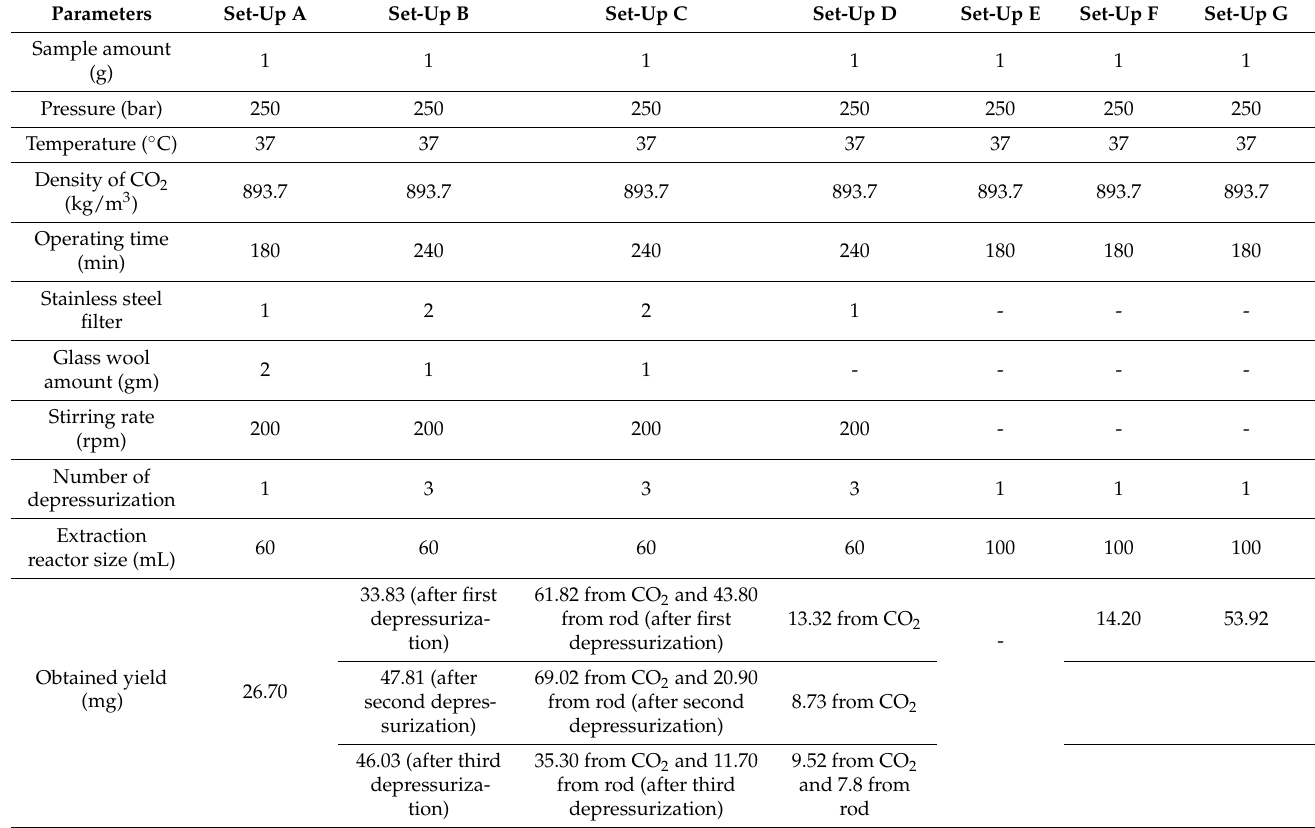
Table 1. Conditions for SCF extraction of cannabinoids from